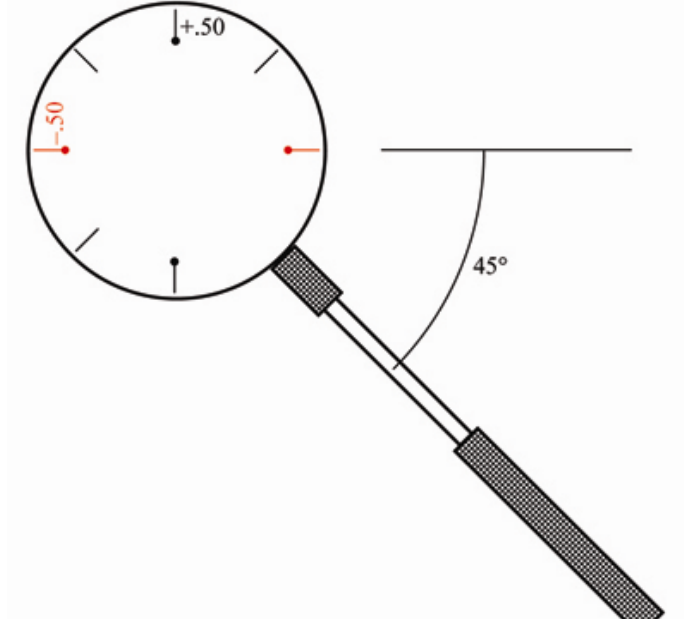
Figure 1 A 0.5-D Jackson cross-cylinder in primary orientation. The handle is down to the right and at 45º to the horizontal. The label +.50 is in the usual orientation for reading;  .50 reads upward. The markings are in red (as here) and white (shown black here). The lens has a front or first surface, the surface facing the reader; the markings are on this surface. The second or back surface of the lens is the surface facing away from the reader. The lens has power given in various representations in Table 1. The two red pins represent the axis of the component cylinder of power  0.5 D; the so-called power meridian of that cylinder is vertical (see Figure 4(a)). The two white pins represent the axis of the component cylinder of power 0.5 D. When the lens is flipped the back surface comes to the front and the markings are reversed; in particular the numbers (  .50 and +.50 ) appear as their mirror images